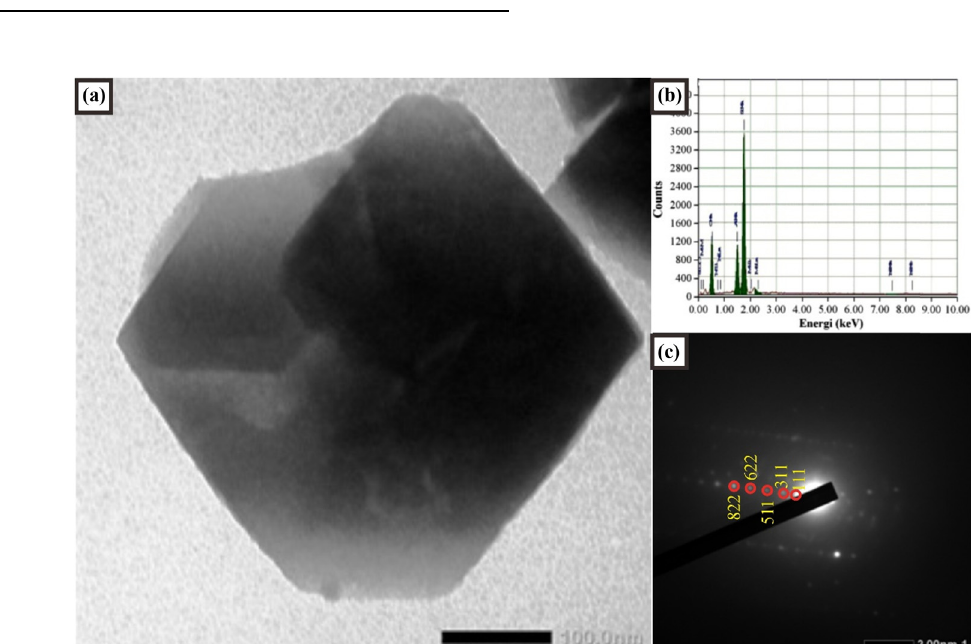
Figure 7: TEM Images of USY ( a ) with a magni fi cation of 50,000 × , ( b ) EDX spectra, and ( c ) di ff raction pattern.